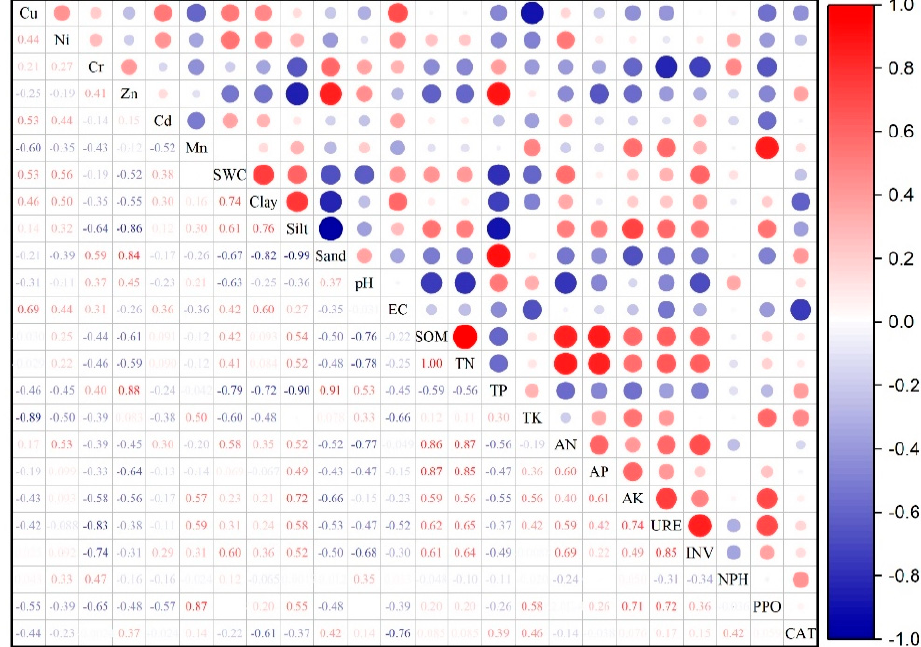
Figure 3. Correlation matrix of soil properties ( n = 30).